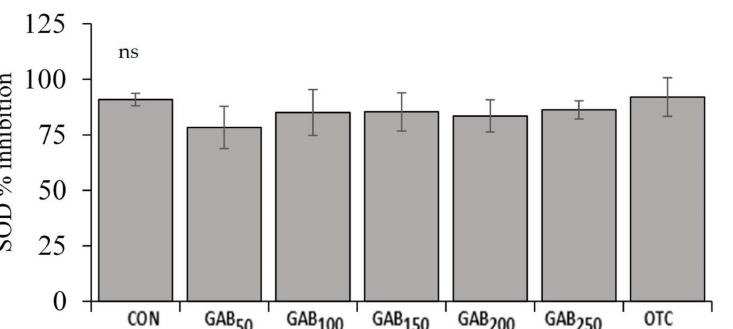
Figure 5. Serum superoxide dismutase (SOD) activity in juvenile olive flounder fed increasing levels of GABA. Values are mean of triplicate samples. See Table 1 for information on diets: CON, GAB 50 , GAB 100 , GAB 150 , GAB 200 , GAB 250 , and